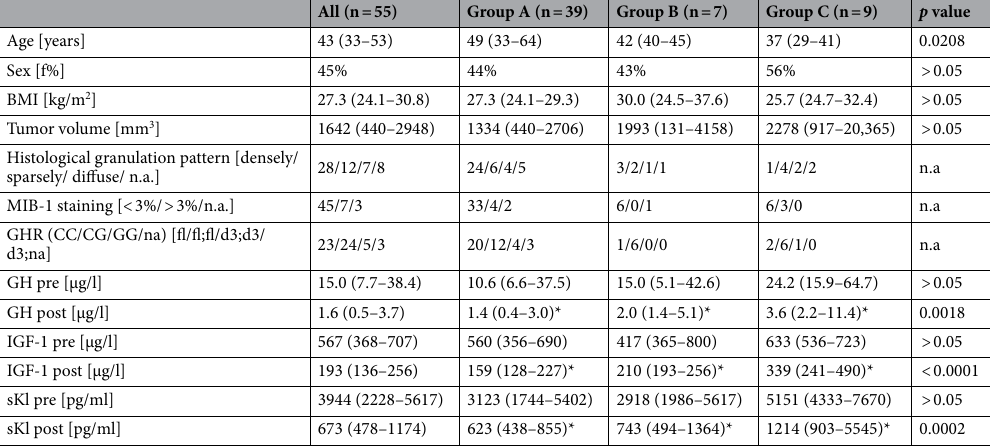
Table 1. Patient characteristics and biomarker